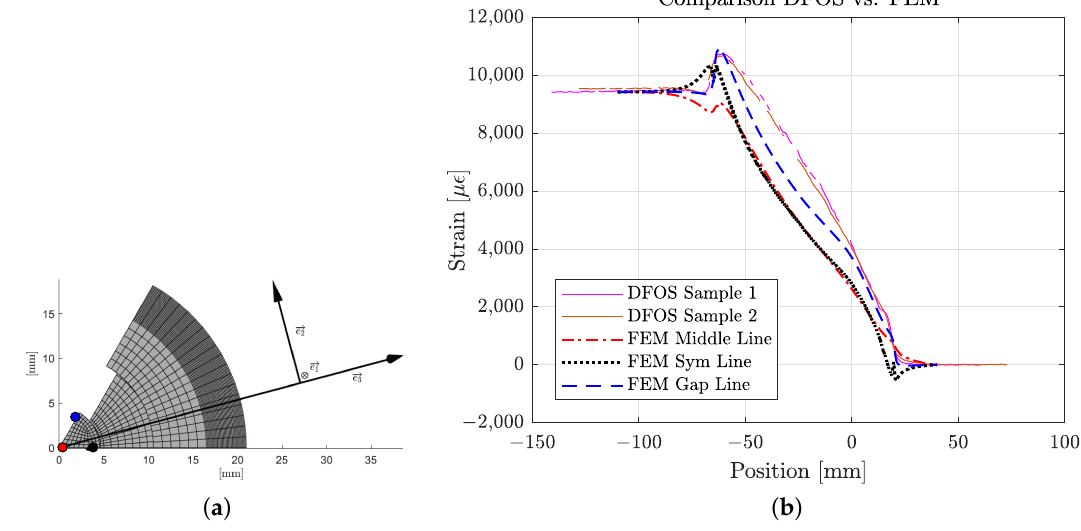
Figure 15. DFOS measurement vs. Finite Element Analysis. ( a ) Definition of analyzed points: (Middle line), (Gap line) and (Symmetry line); ( b ) strain distribution in the anchorage at σ = 1400 MPa.